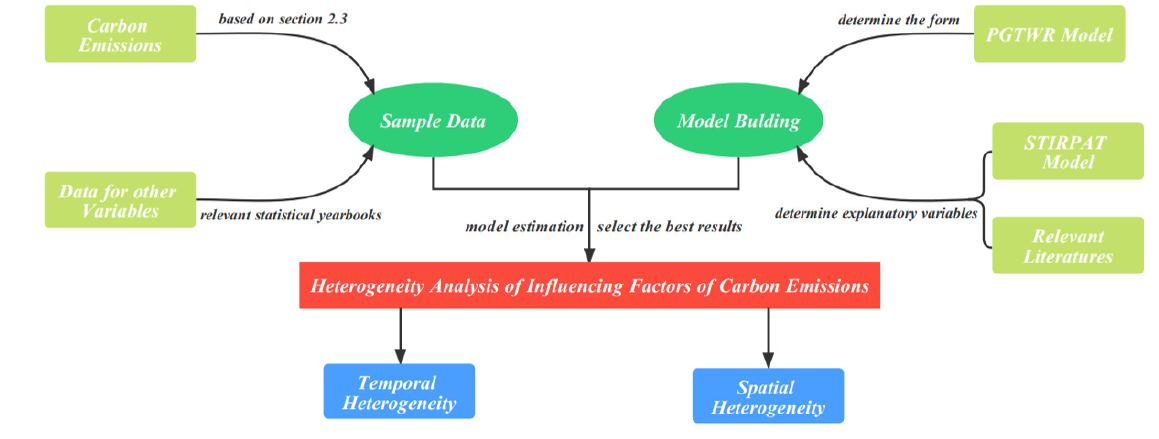
Figure 2. An overview of Materials and Methods. Table 2. Calculation of CO 2 emission